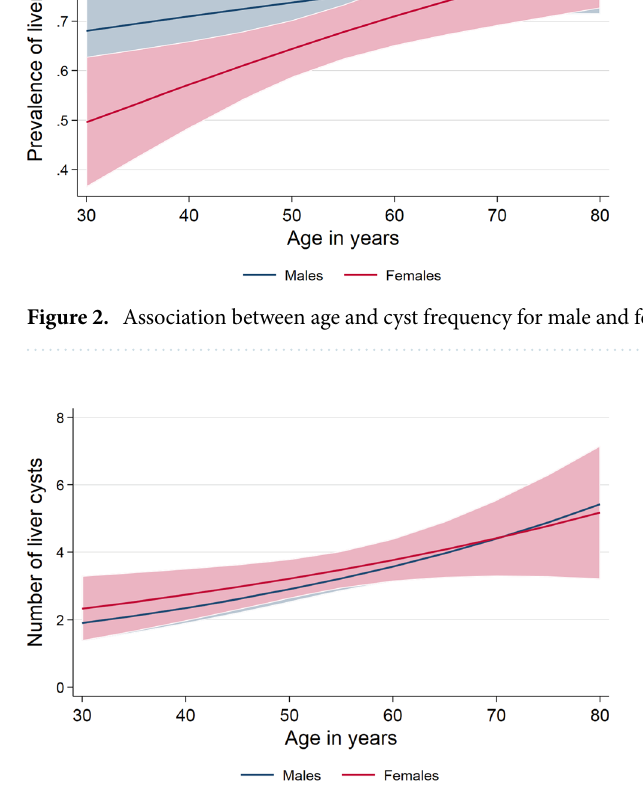
Figure 3. Association between mean number of cysts and age for male and female volunteers.